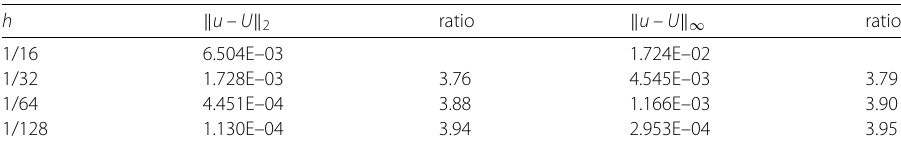
Table 1 The errors for finite difference method in two norms h (cid:5) u – U (cid:5) 2